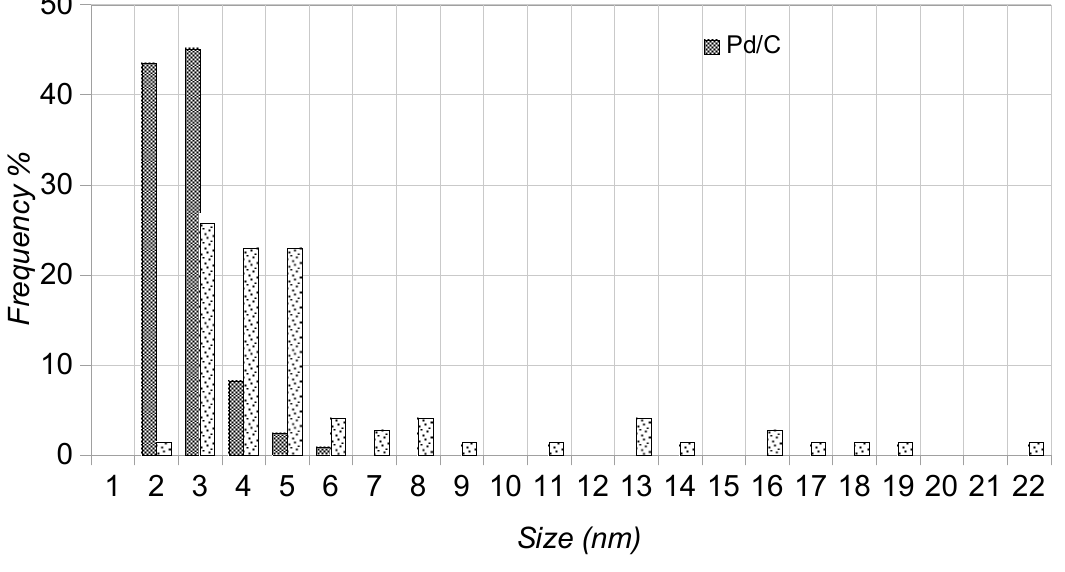
Figure 7. Particle size distribution for Pd/C (122 NPs) and Pd/µS-pDVB10 (74 NPs).